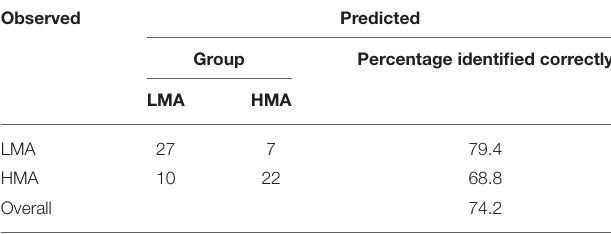
LMA, low mathematical anxiety; HMA, high mathematical